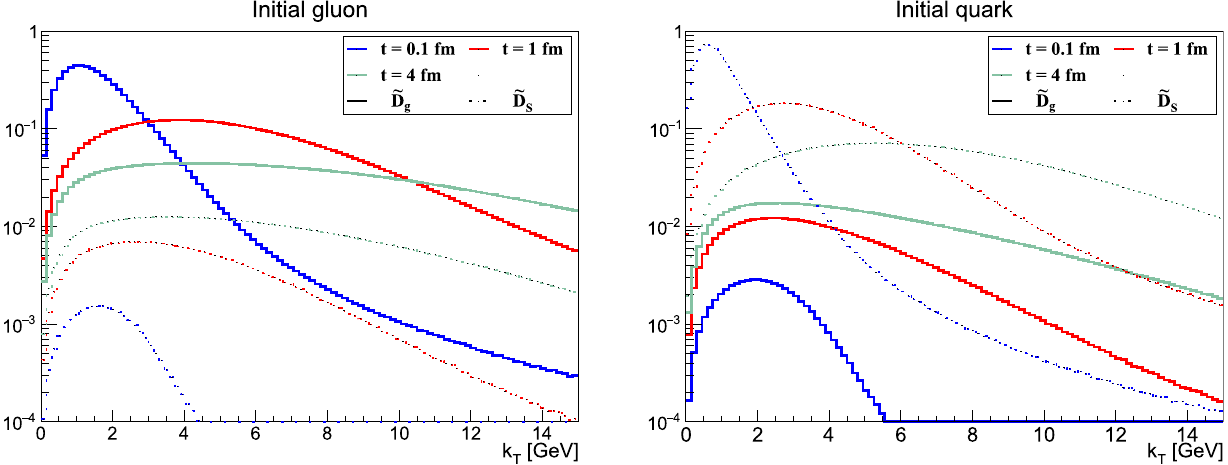
+ l 2 ) ] at the time-scales t = 0 . 1 , 1 , 4fm: cascades initiated by gluon (left) and quark Fig. 4 The ˜ D ( k T , t ) distributions for w( l ) ∝ 1 / [ l 2 ( m 2 D (right). The dashed lines correspond to the quark distributions while the solid lines to the gluon